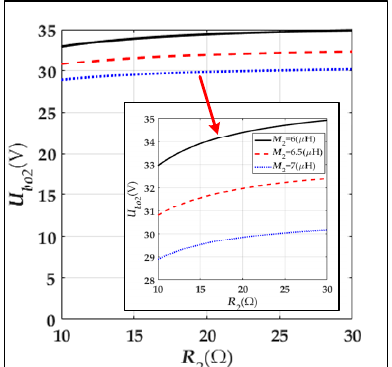
Figure 6. The variation of the output voltage with the mutual inductance and the load in Mode B.